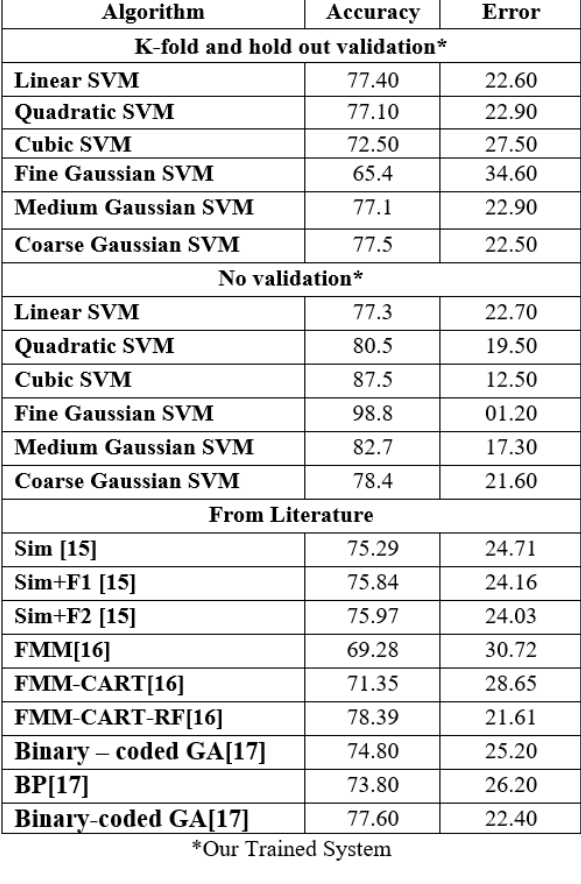
Table 9. Performance Comparison